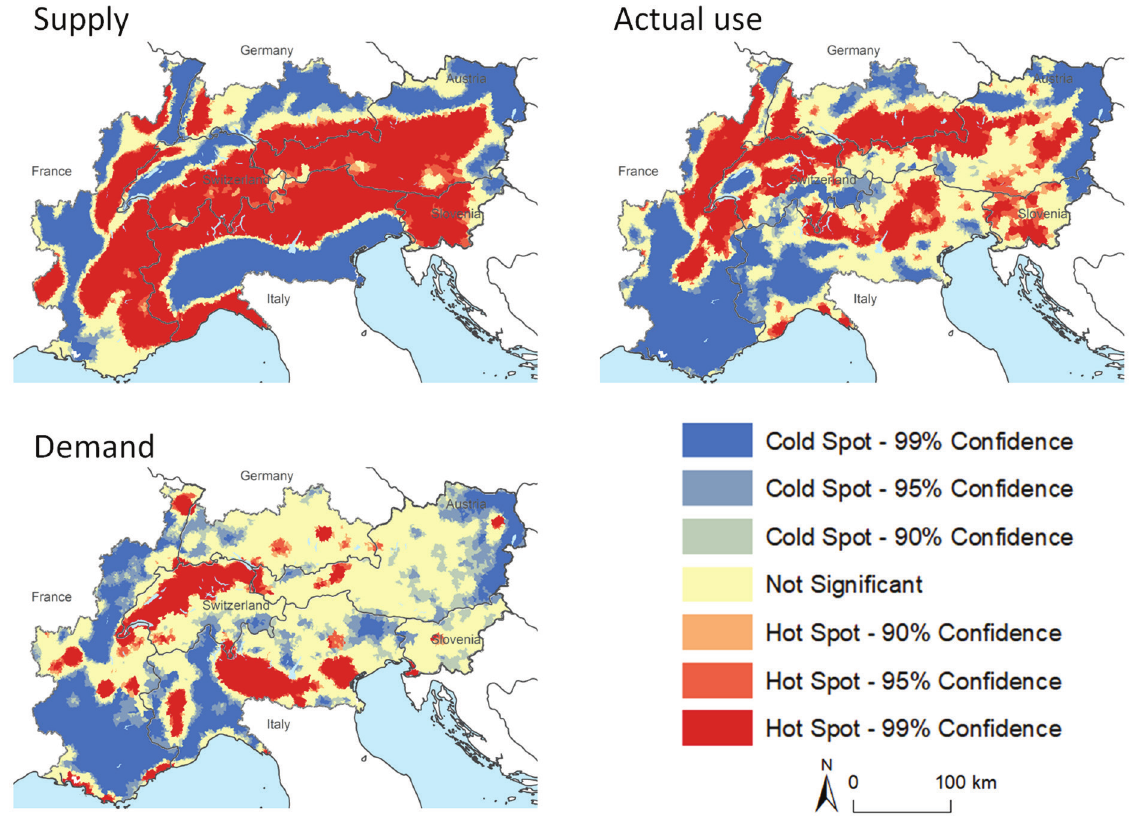
Figure 5. Hotspots of supply, actual use and demand for multiple ES in the Alpine Space area. ES include freshwater, grassland biomass, fuel wood, filtration of surface water, protection against mountain hazards, carbon sequestration, outdoor recreations, symbolic plants and animals. Data sources: Schirpke et al. (2019b).